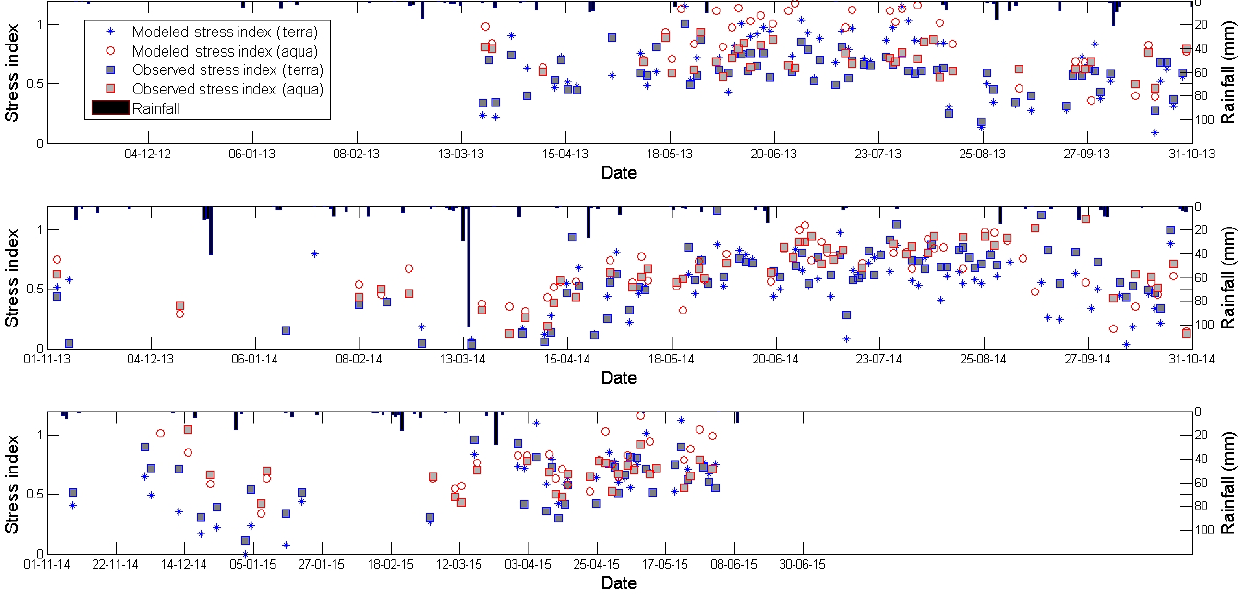
Figure 10. Modeled and observed stress index evolution at Terra and Aqua overpass times compared to daily